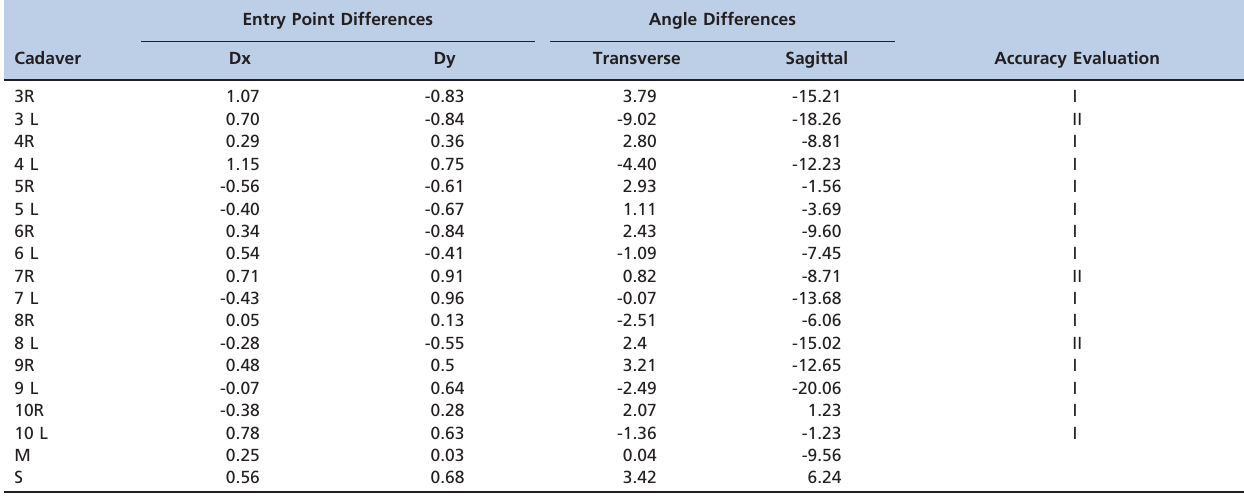
Table 2 - Comparison of Planned vs . Inserted Screws (Stage